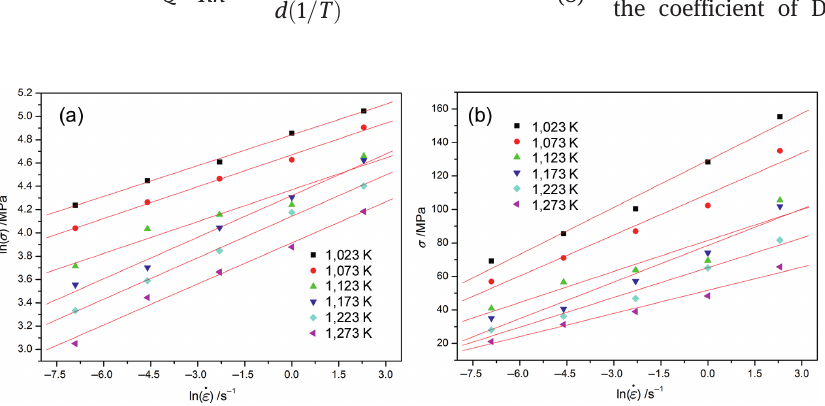
Figure 5: Relationship between: (a) ln( σ ) and ln( _ ε ) (b) σ and ln( _ ε ).